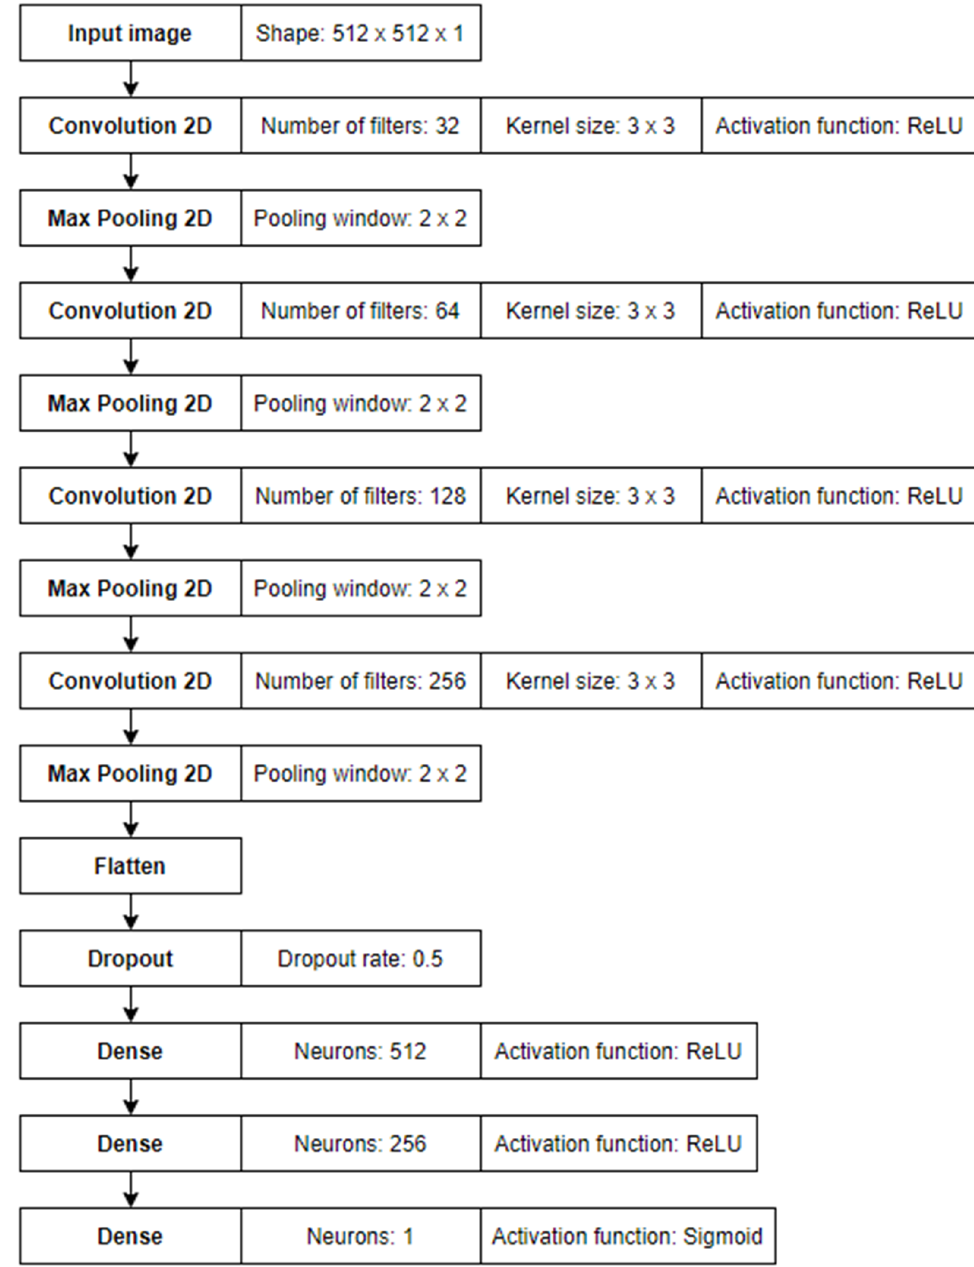
Figure 9. Neural network architecture.